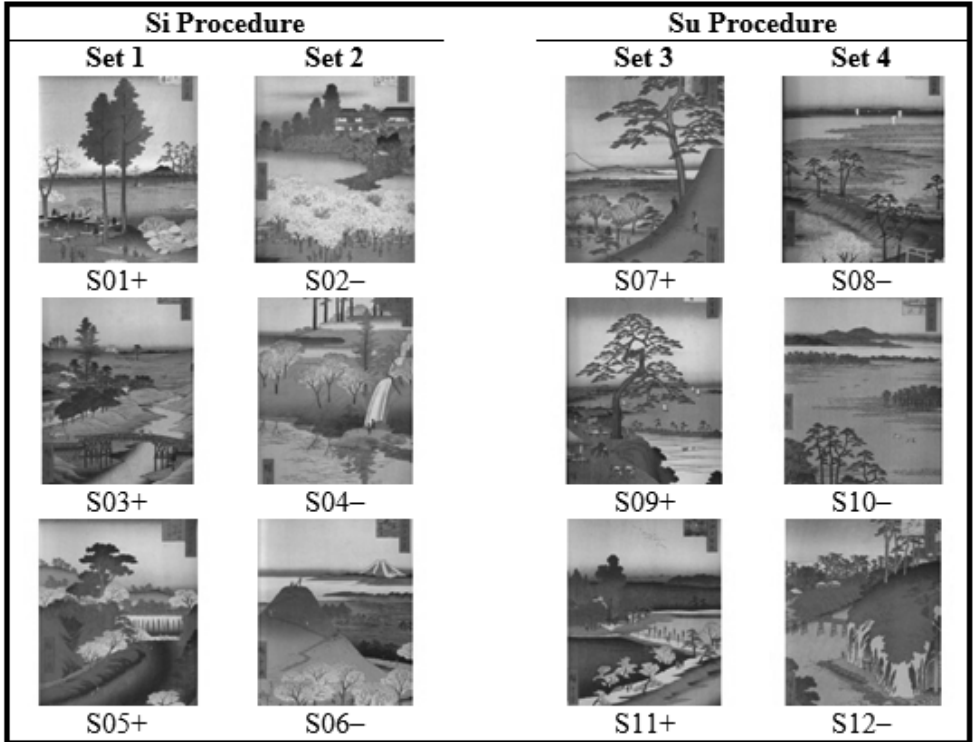
Figure 1 . Sets of stimuli used in the Si Procedure and the Su